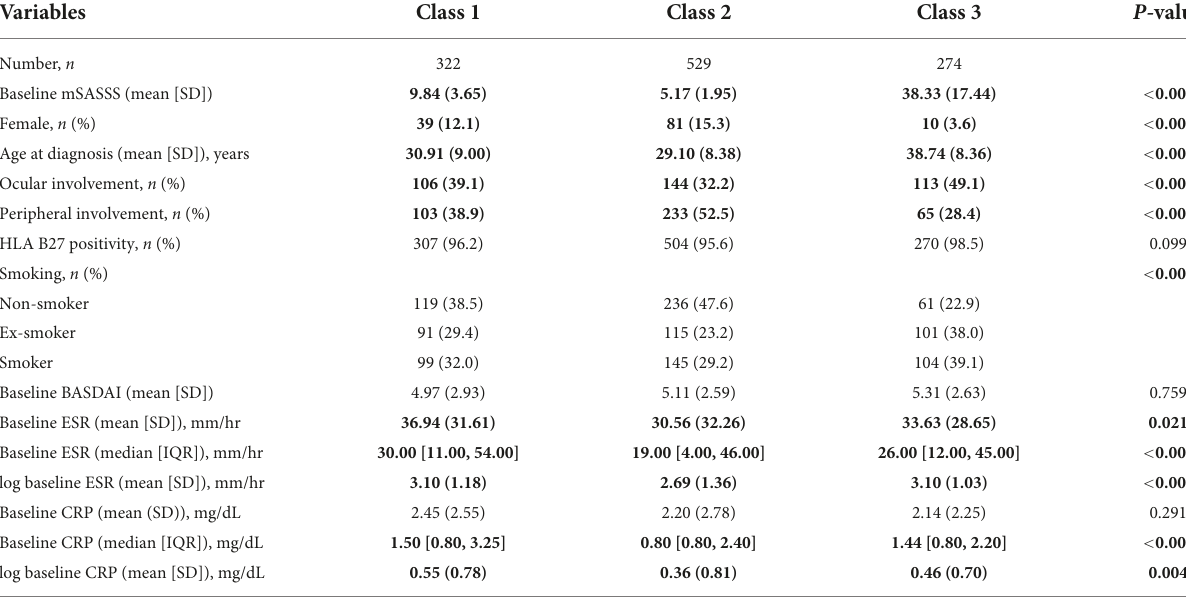
TABLE 2 Comparison of trajectory group membership in the three-class mSASSS model for disease duration.